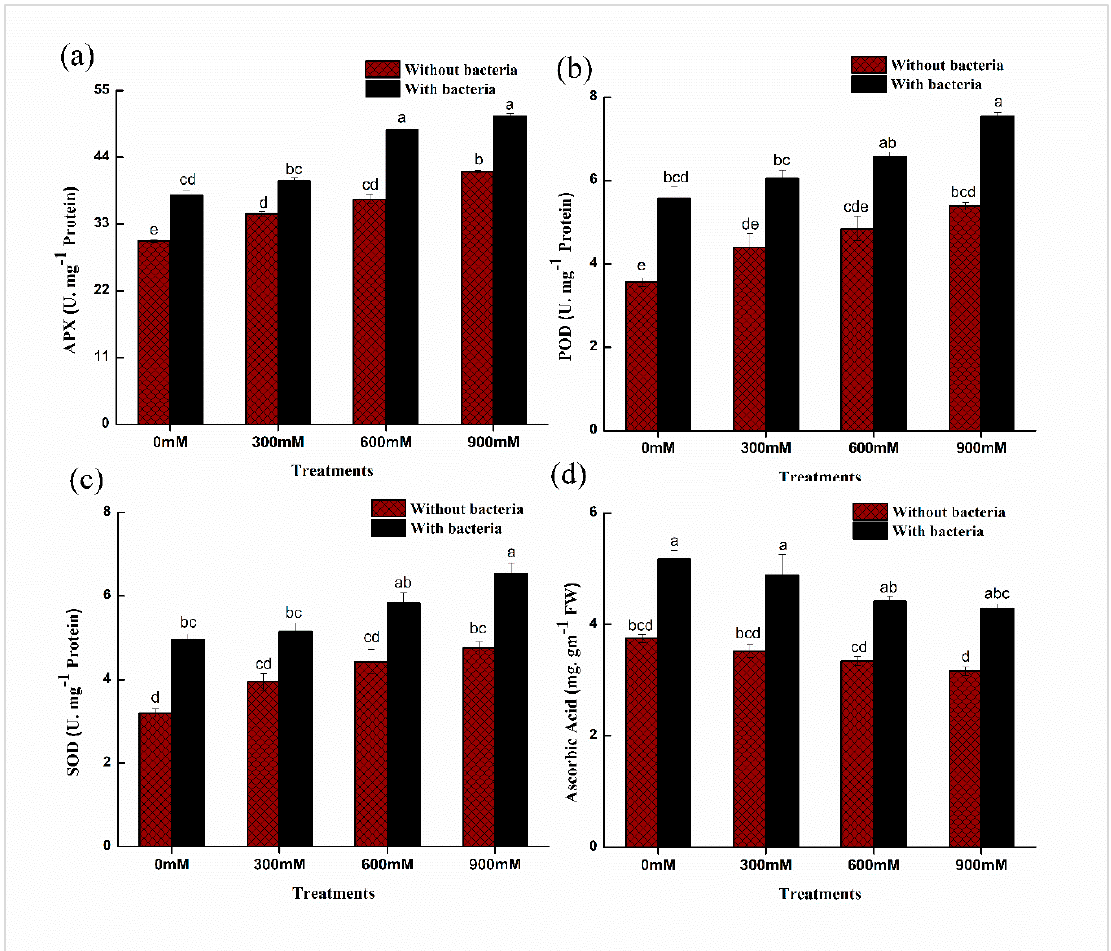
Figure 4. Effects of E. cloacae PM23 on levels of enzymatic and non-enzymatic antioxidants: ( a ) Ascorbate peroxidase (APX) ( b ) Peroxidase (POD) ( c ) Superoxide dismutase (SOD) ( d ) Ascorbic Acid. The a, b, c, d, e inside the figure (on top of the bar graphs) refer to the same meaning in the caption.